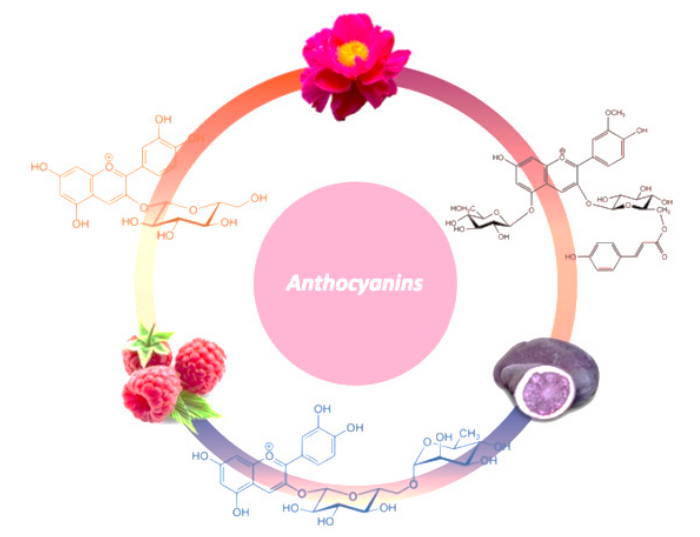
Figure 3. Anthocyanins’ sources and their chemical patterns.